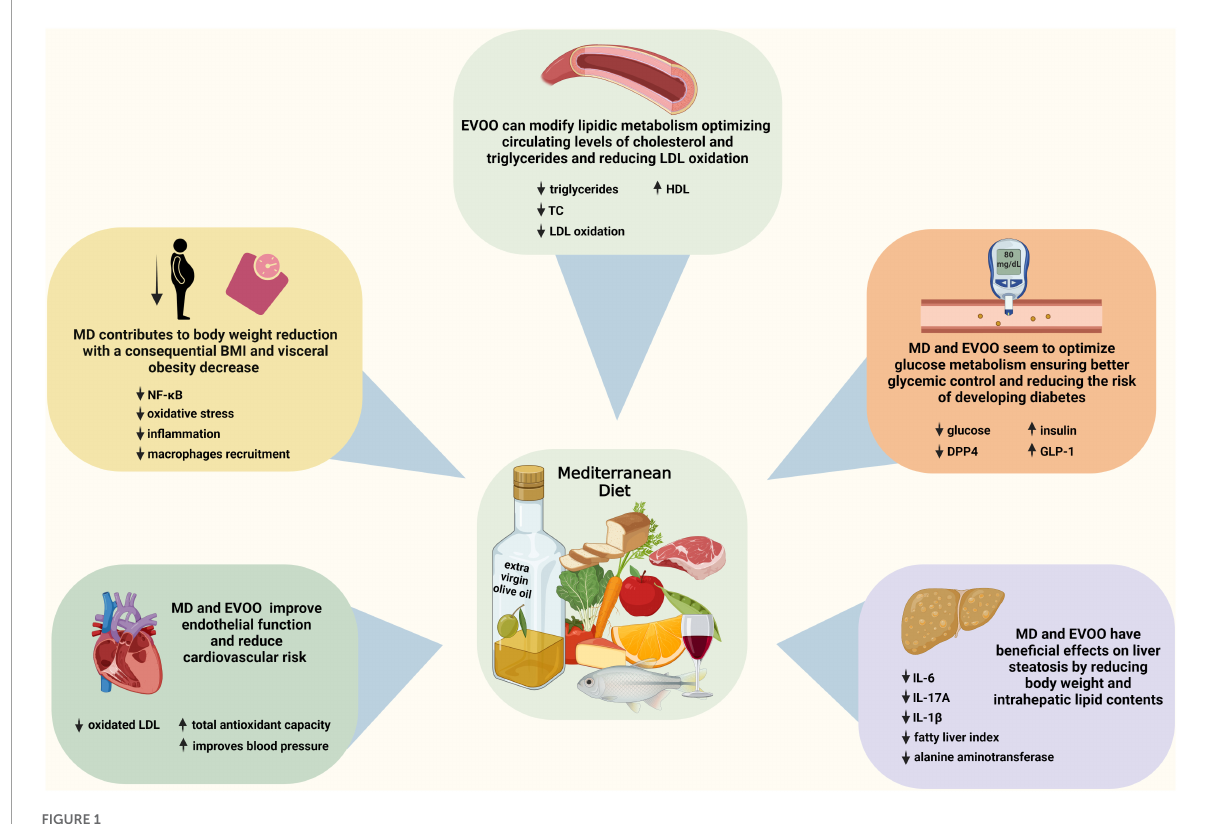
FIGURE1 Beneficial effects of the mediterranean diet (MD) and extra virgin olive oil. Some key alterations implicated in MD and EVOO effects are presented. Created with